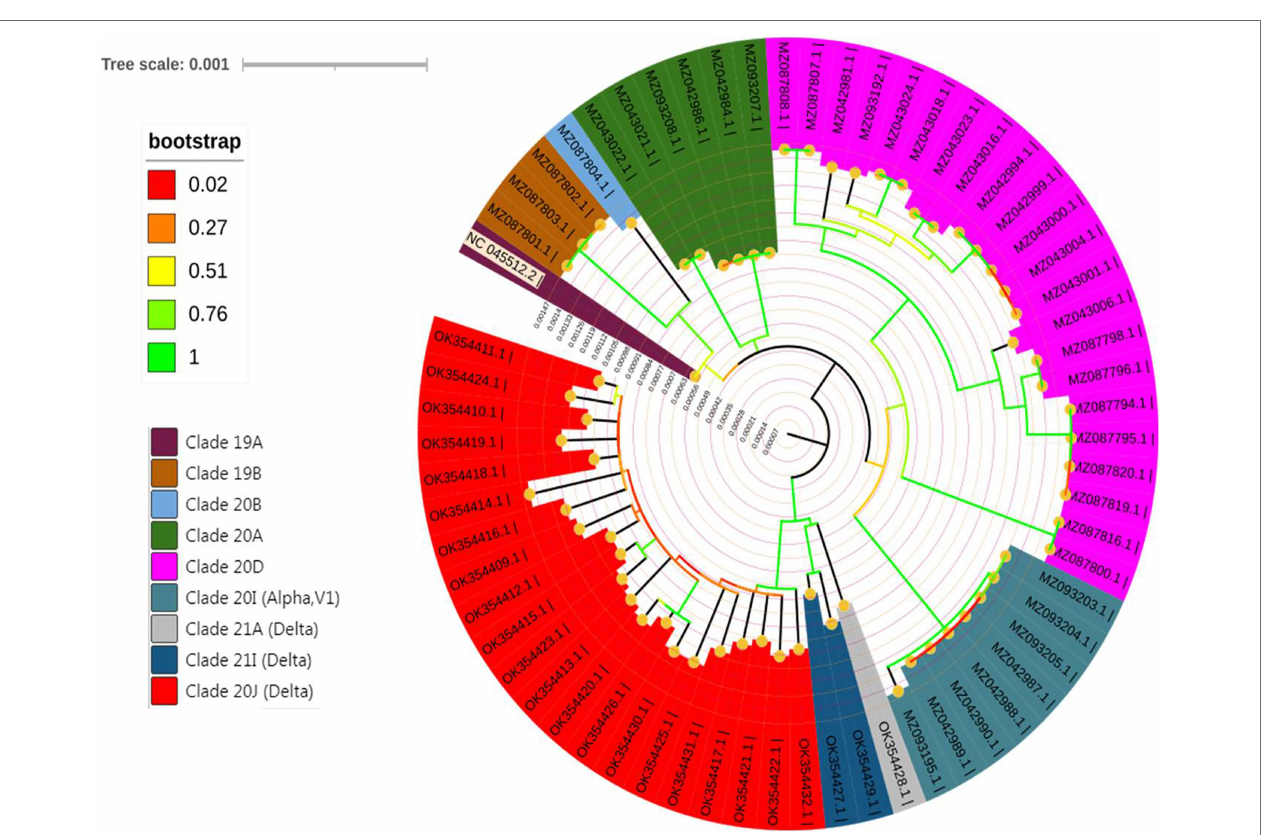
FIGURE 6 | Molecular phylogenetic analysis by the Maximum Likelihood method.